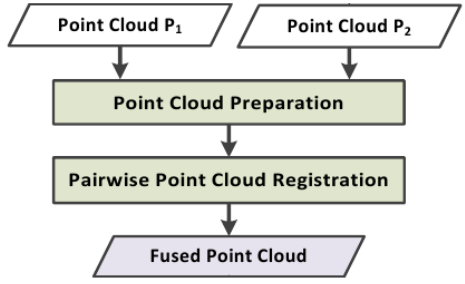
Figure 2: Pairwise point cloud fusion pipeline